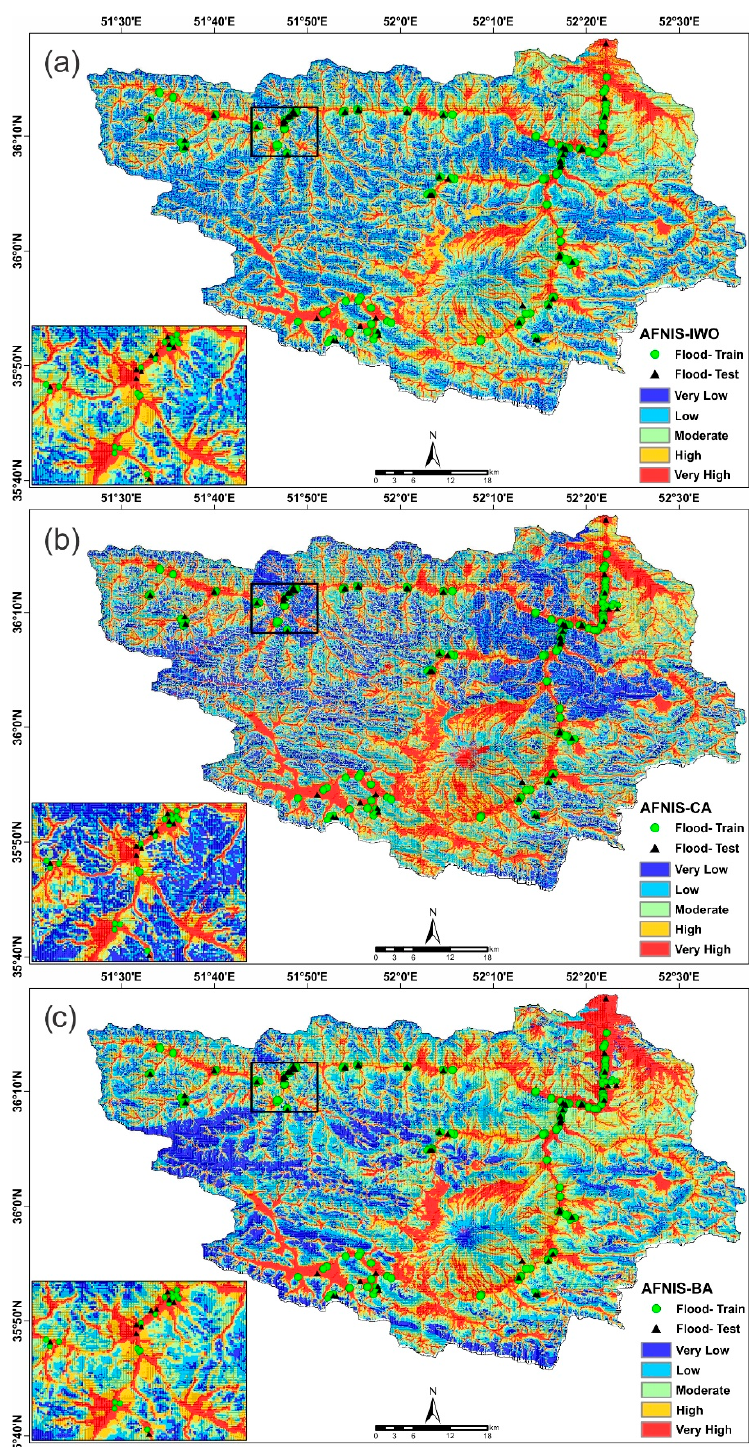
Figure 12. FSM using ANFIS-IWO ( a ), ANFIS-CA ( b ), and ANFIS-BA ( c ) for Haraz watershed.